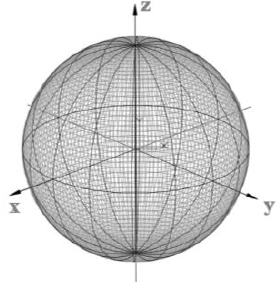
Fig. 24. General view of the reflector with fixed to it knitted mesh fabric. Steps of CAS deployment and the CAS framework in the unfolded state are shown in Fig. 25.